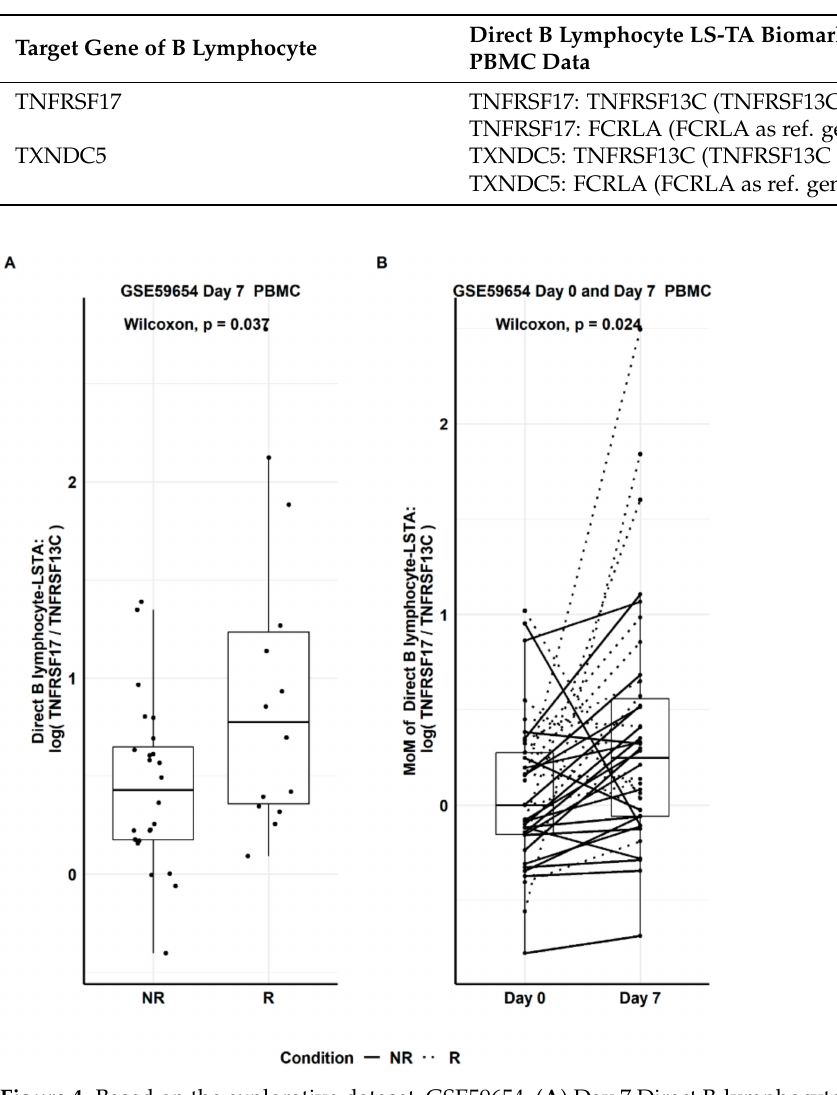
Figure 4. Based on the explorative dataset, GSE59654, ( A ) Day 7 Direct B-lymphocyte LS-TA results of TNFRSF17 in responder (R) and non-responder (NR) groups. ( B ) Paired Day 0 and Day 7 change in Direct LS-TA expressed as multiples of median (MoM) using the Day 0 group